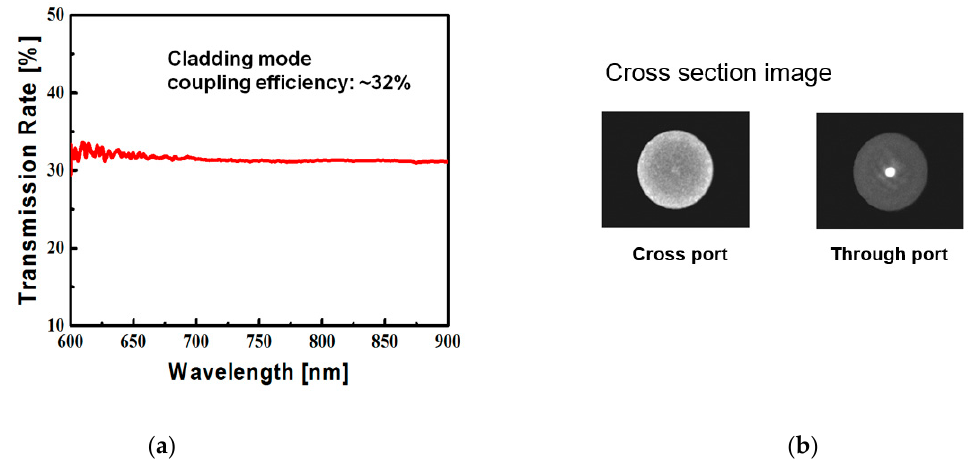
Figure 4. ( a ) Transmission rate of the inner cladding of the coupler. ( b ) Mode field images of the DCF coupler (left: the cross port of the DCF coupler shown in Figure 1; right: the through port of the DCF coupler shown in Figure 1).